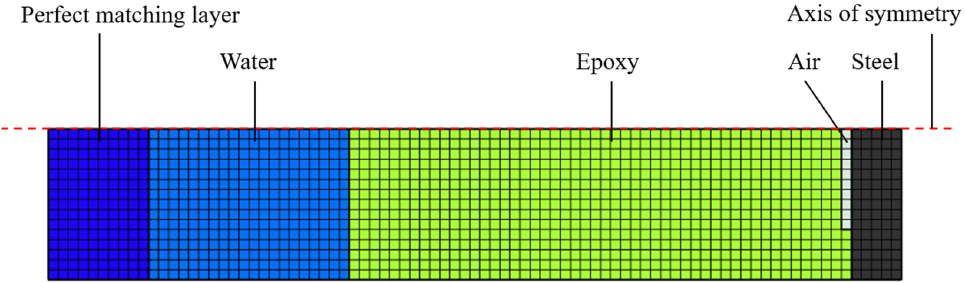
Figure 3. Finite element model of UAL of SSC.